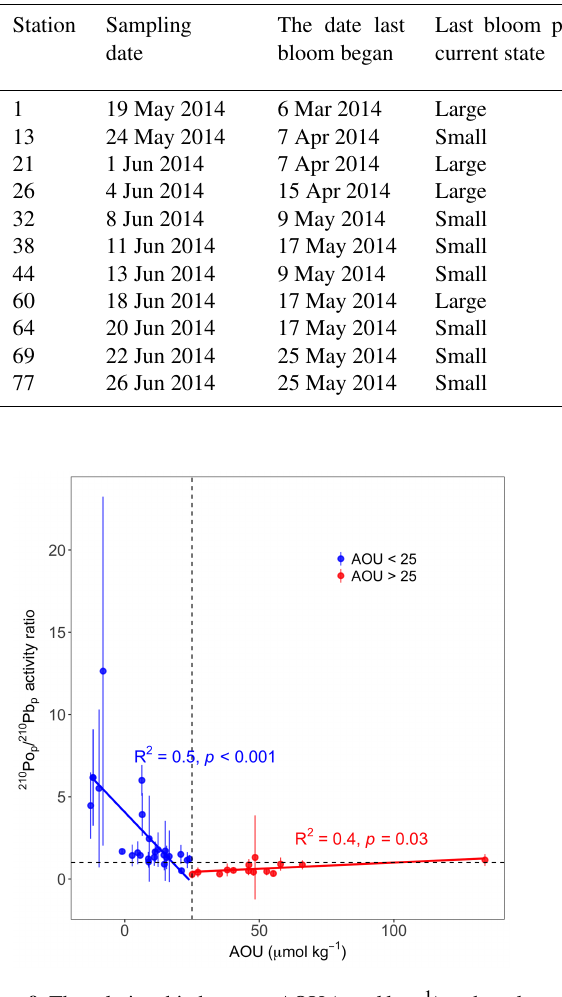
– in the North Atlantic. The horizontal dashed line represents 210 Po 210 Pb p / p AR = 1, and the vertical dashed line represents AOU = 25µmolkg − 1 . Blue circles denote AOU < 25µmolkg − 1 , while red circles denote AOU > 25µmolkg − 1